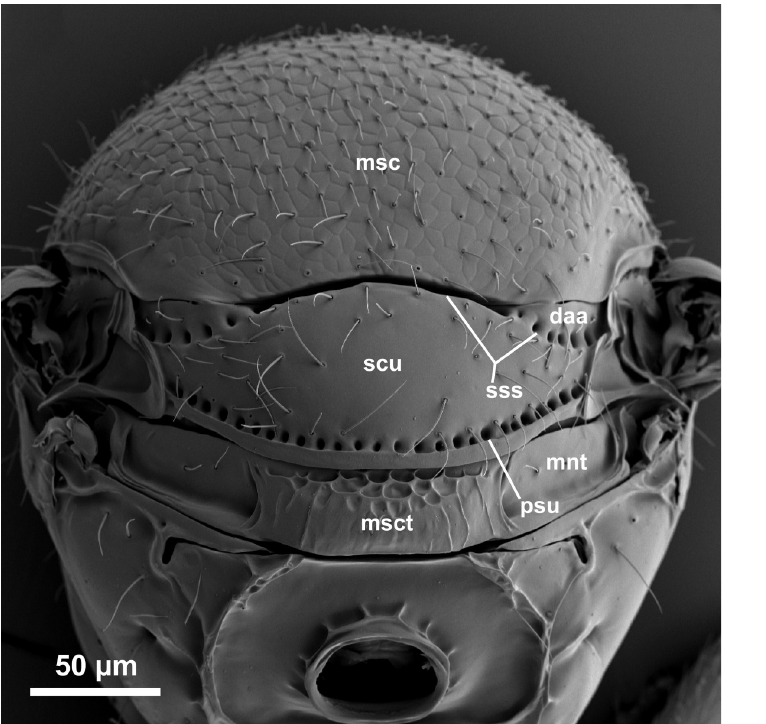
Fig 5. Telenomus nizwaensis Polaszek male paratype. Lateral mesosoma.